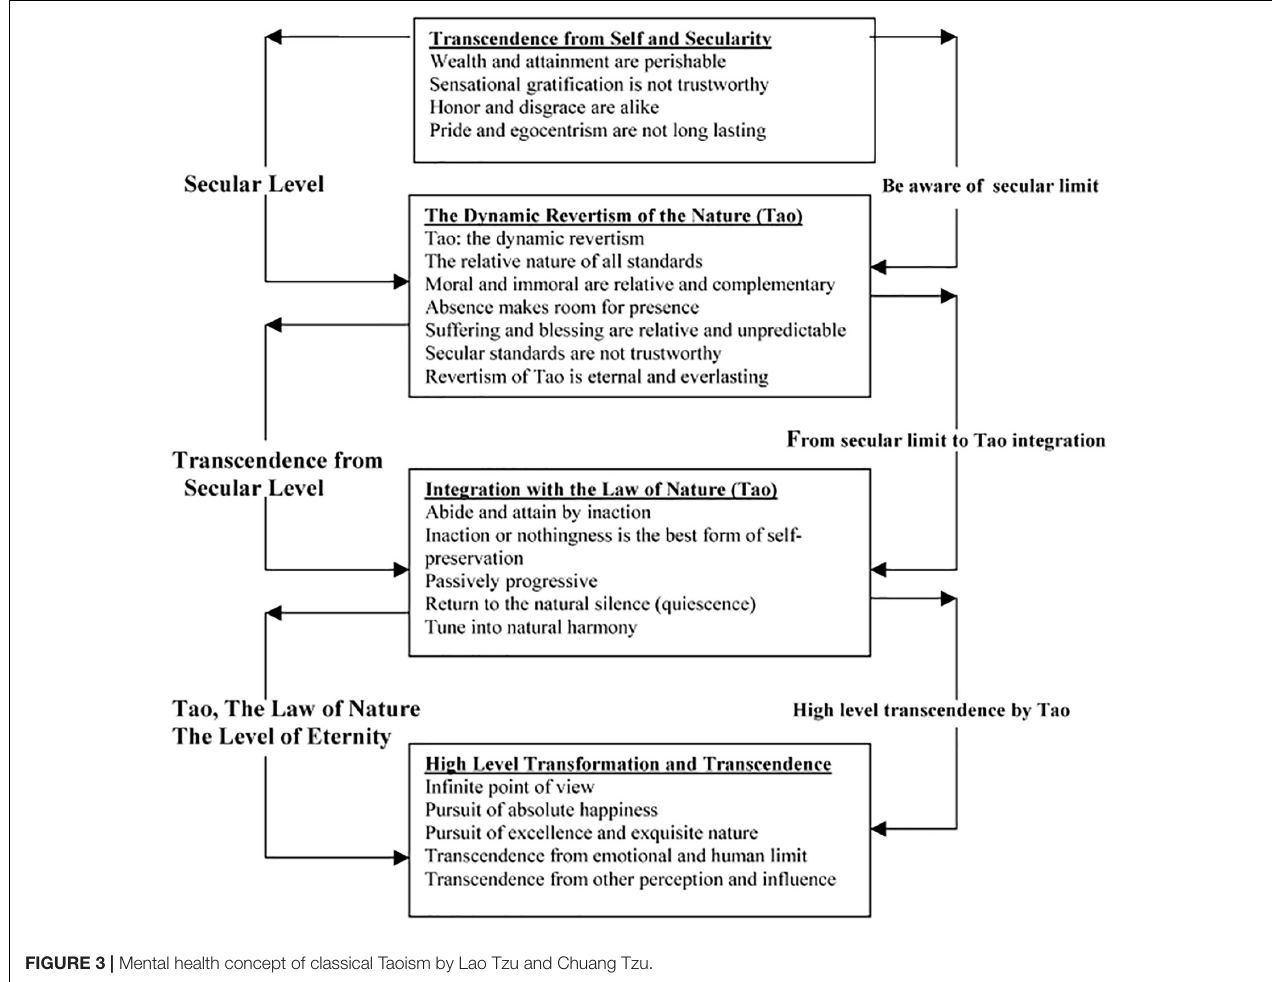
FIGURE 3 | Mental health concept of classical Taoism by Lao Tzu and Chuang Tzu.